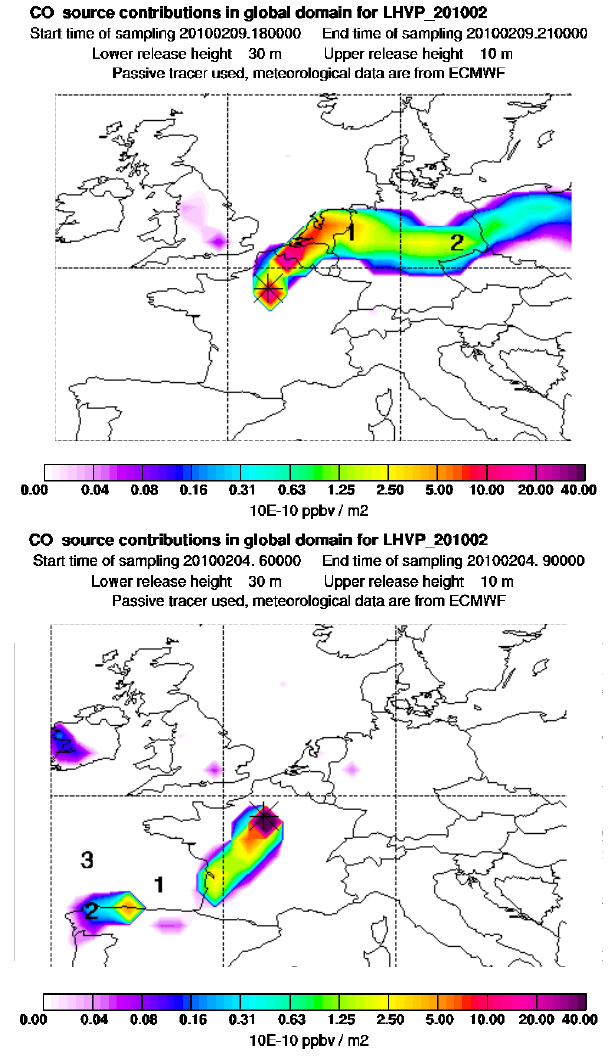
Fig. 3. Maps showing the typical CO source contributions observed for the continental (a) and oceanic (b) wind regime during the mea- surement campaign at